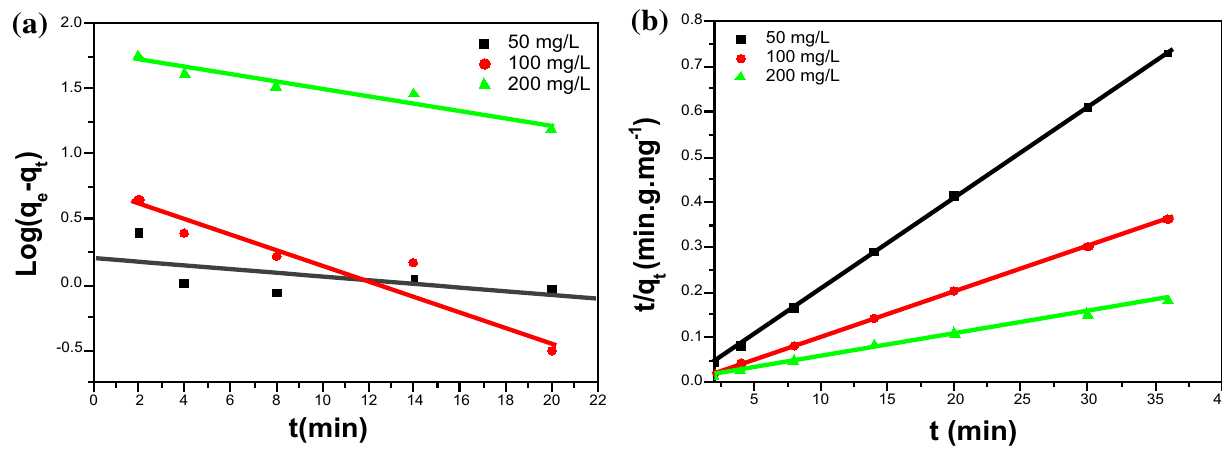
Fig. 4 Pseudo-first-order model ( a ) and pseudo-second-order model ( b ) plots for the adsorption of AG1 onto LDH at different initial dye con-